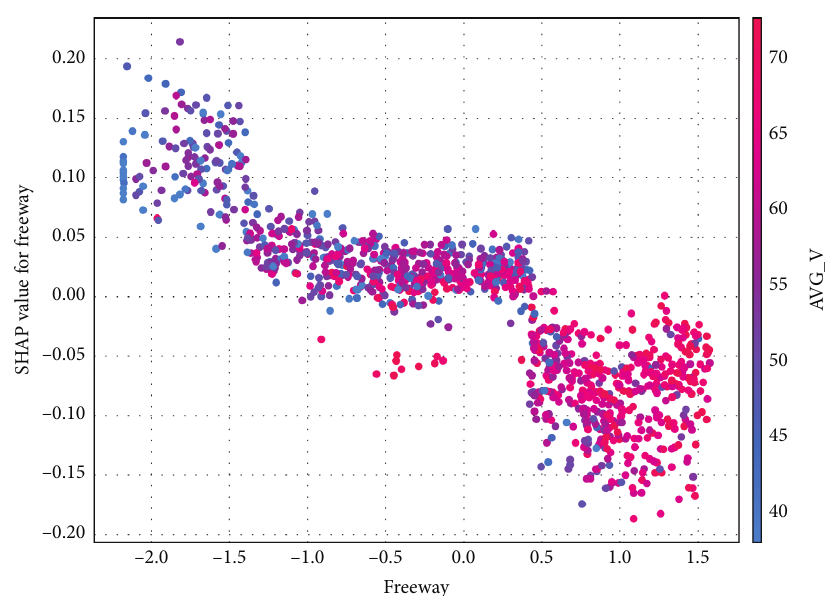
Figure 13: The global impact of freeways on fuel